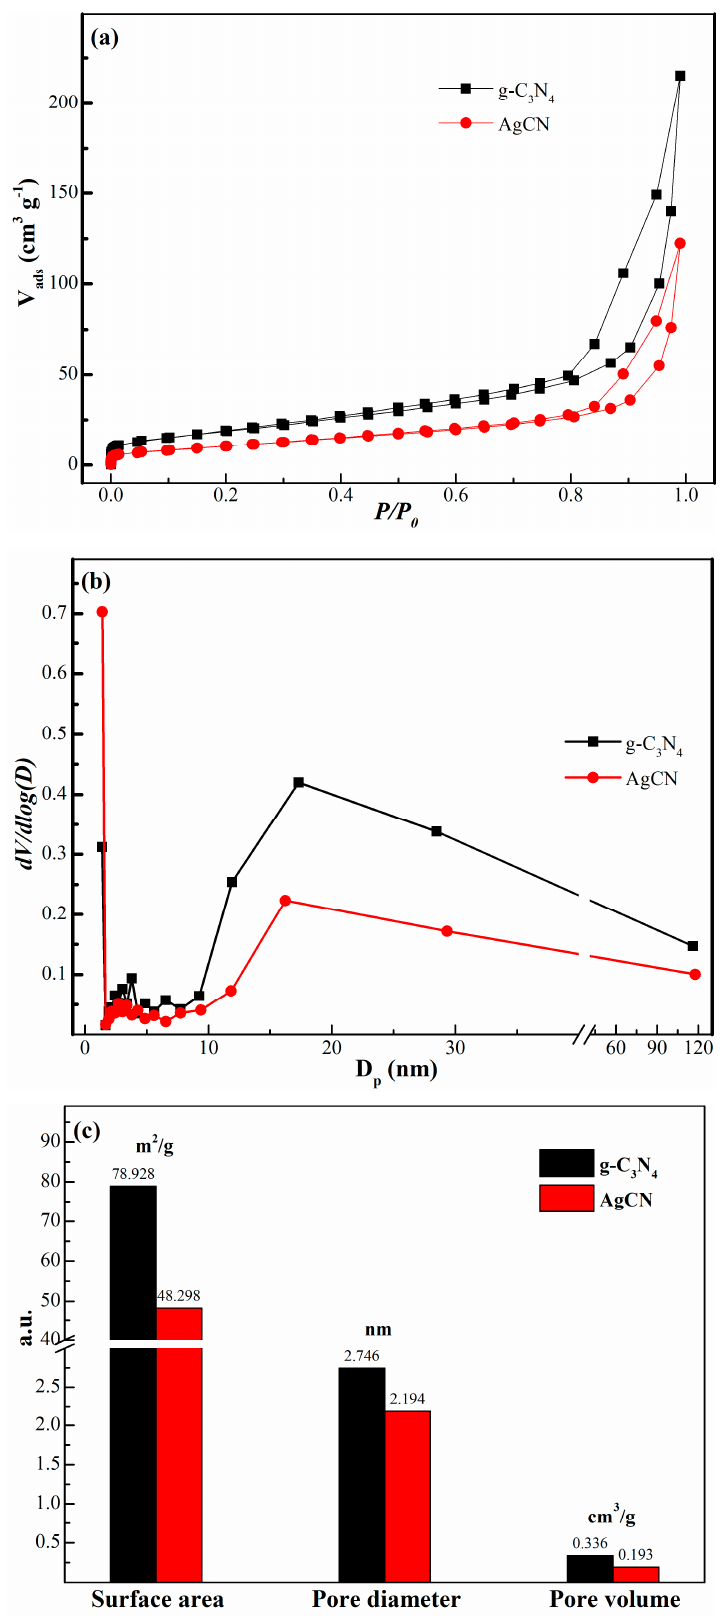
Figure 3. Nitrogen gas adsorption–desorption isotherms ( a ); BJH pore-size distribution curves ( b ); and ( c ) S BET of the g-C 3 N 4 and AgCN composite photocatalysts.